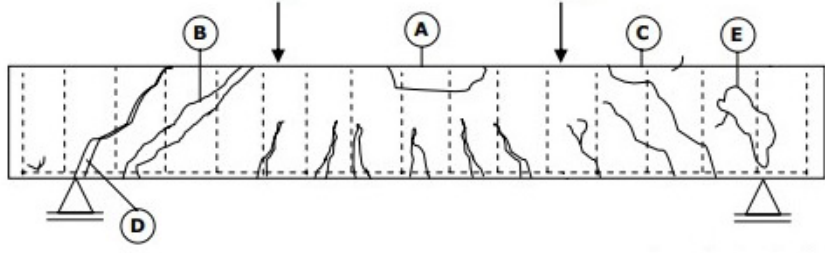
Figure 15. Possible fracture modes in the 4-points bending test 43 .